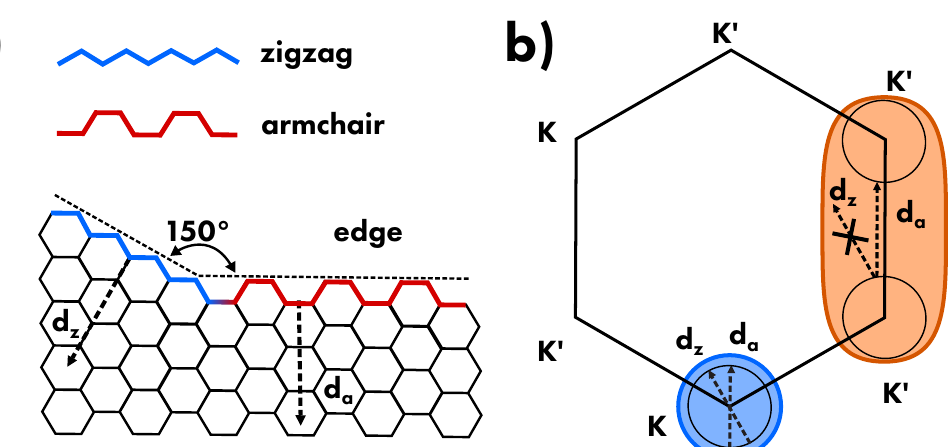
Figure 22. ( a ) Different edge structures for graphene: zigzag (blue) and armchair (red), and their respective momenta transferred to scattered electrons ( d z and d a ). ( b ) Wavevector change by scattering at different types of edge, and consequent contribution to Raman scattering bands. Adapted with permission from Ref. [53]. Copyright (2011) Wiley.